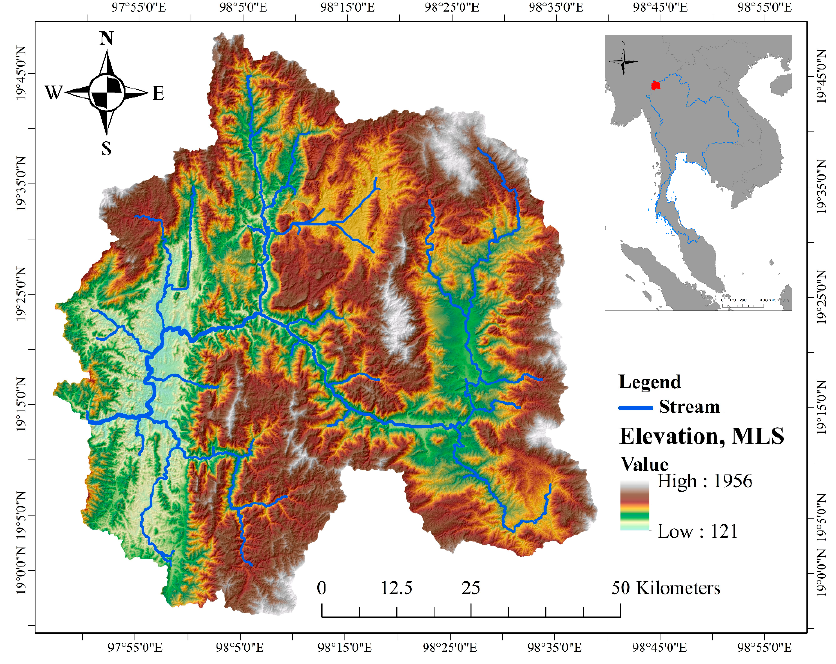
Figure 1. Elevation and river network of the study area.